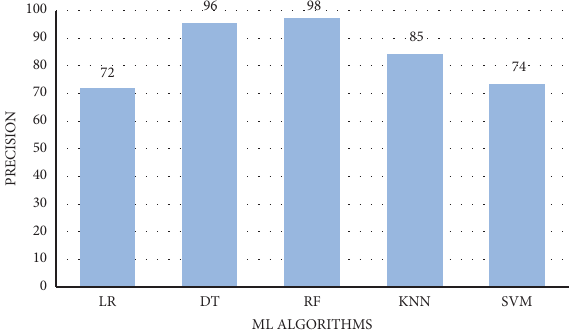
Figure 9: Comparison of precision.